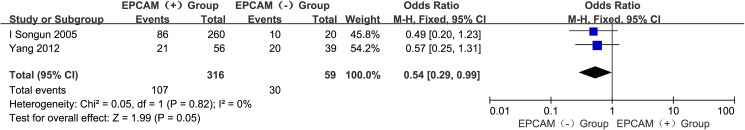
Meta-analysis of 5-year overall survival between EpCAM (+) and EpCAM (–) groups.